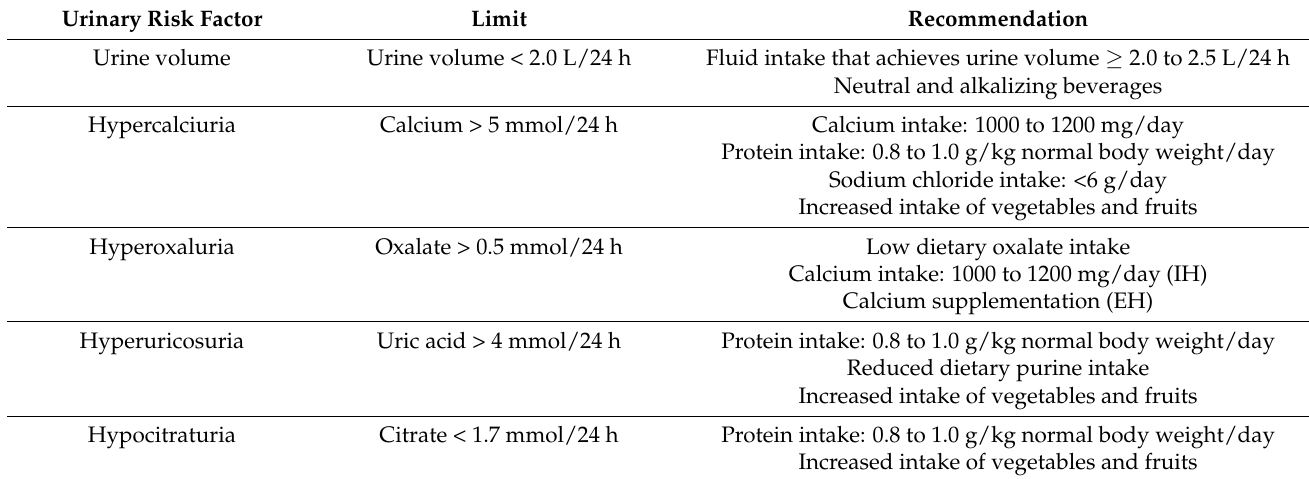
Table 4. Dietary recommendations for calcium oxalate stone